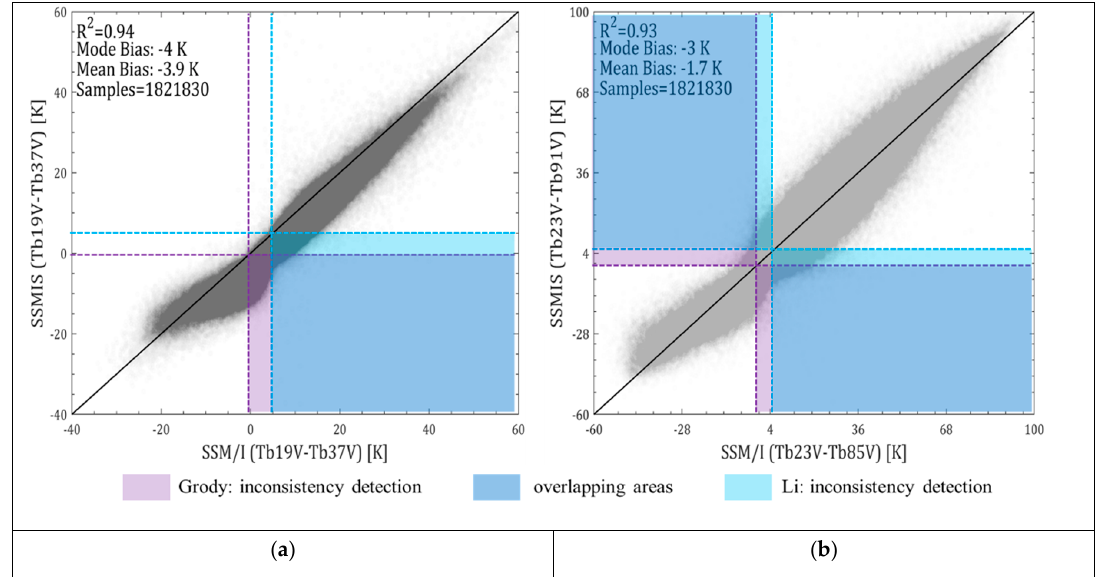
Figure 7. Scatter plots of brightness temperature gradient between SSM/I and SSMIS (a) Tb 19V ‒ Tb 37V ; (b) Tb 23V ‒ Tb 85V . The light blue dashed line denotes that the threshold is 5 K for the Li algorithm. The purple dashed line represents that the threshold is 0 K for the Grody algorithm.